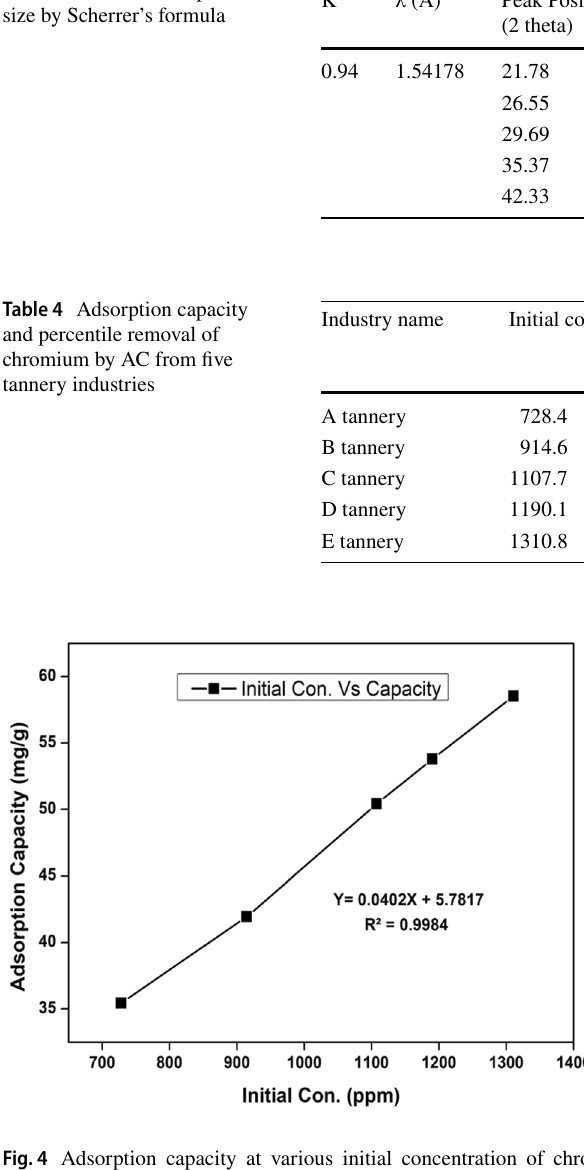
Table 3 Estimation of particle